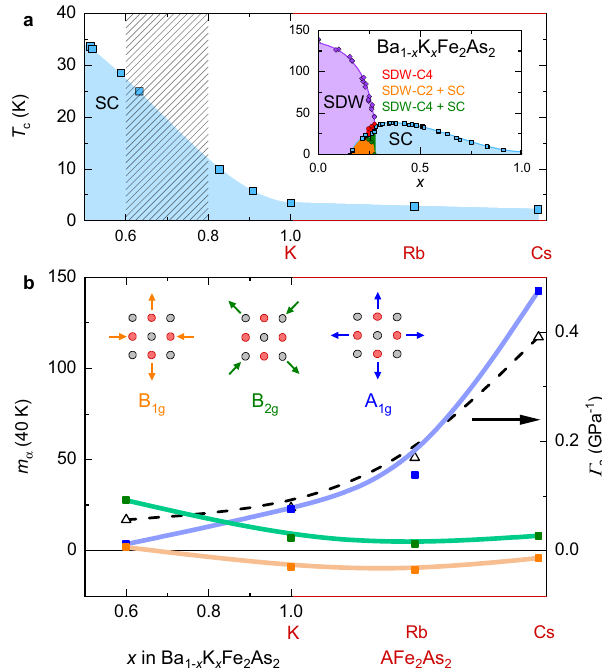
Fig. 6 Evolution of the elastoresistance coef fi cients with chemical substitution. a Phase diagram of the hole-doped series Ba 1 − x K x Fe 2 As 2 for x > 0.5 and the isoelectronic series 3 d 5.5 series AFe 2 As 2 (A = K, Rb, Cs) on the same horizontal axis. The hashed area denotes the doping range of a Lifshitz transition 58 – 61 and proposed broken time-reversal symmetry in the SC state 62 – 64 . XY -type nematic fl uctuations were suggested in the same doping range in the related system Ba 1 − x Rb x Fe 2 As 2 39 . Inset: full thermodynamic phase diagram of Ba three symmetry channels. The black triangles (right axis) represent the in- plane electronic Grüneisen parameter Γ , for comparison with (cid:1) m A . Note the 1 g (cid:4) α elec = C elec ¼ (cid:2)ð d γ = dp Þ = γ where p experimental de fi nition 34,51 Γ a is the a a a in-plane uniaxial